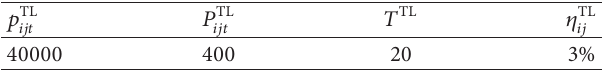
Table 4: Coefficients of transmission line.